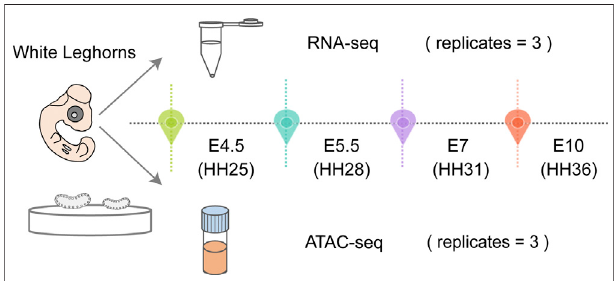
FIGURE 1 | Schematic representation of chicken embryos with left and right gonads dissected for RNA-seq and ATAC-seq at each time point in